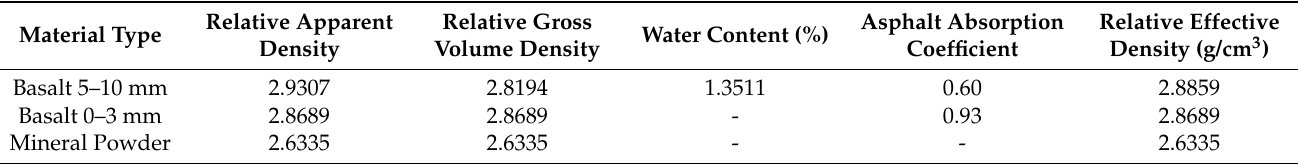
Table 4. Summary of aggregate density of each